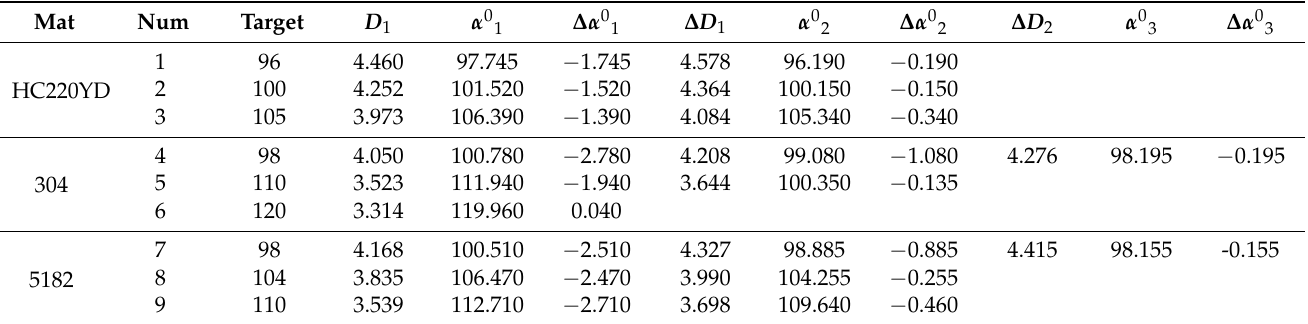
Figure 10. Bending samples, where 1–3 are HC220YD steel, 4–6 are 304 stainless steel, and 7–9 are 5182 aluminum. Table 10. Bending tests of the correction